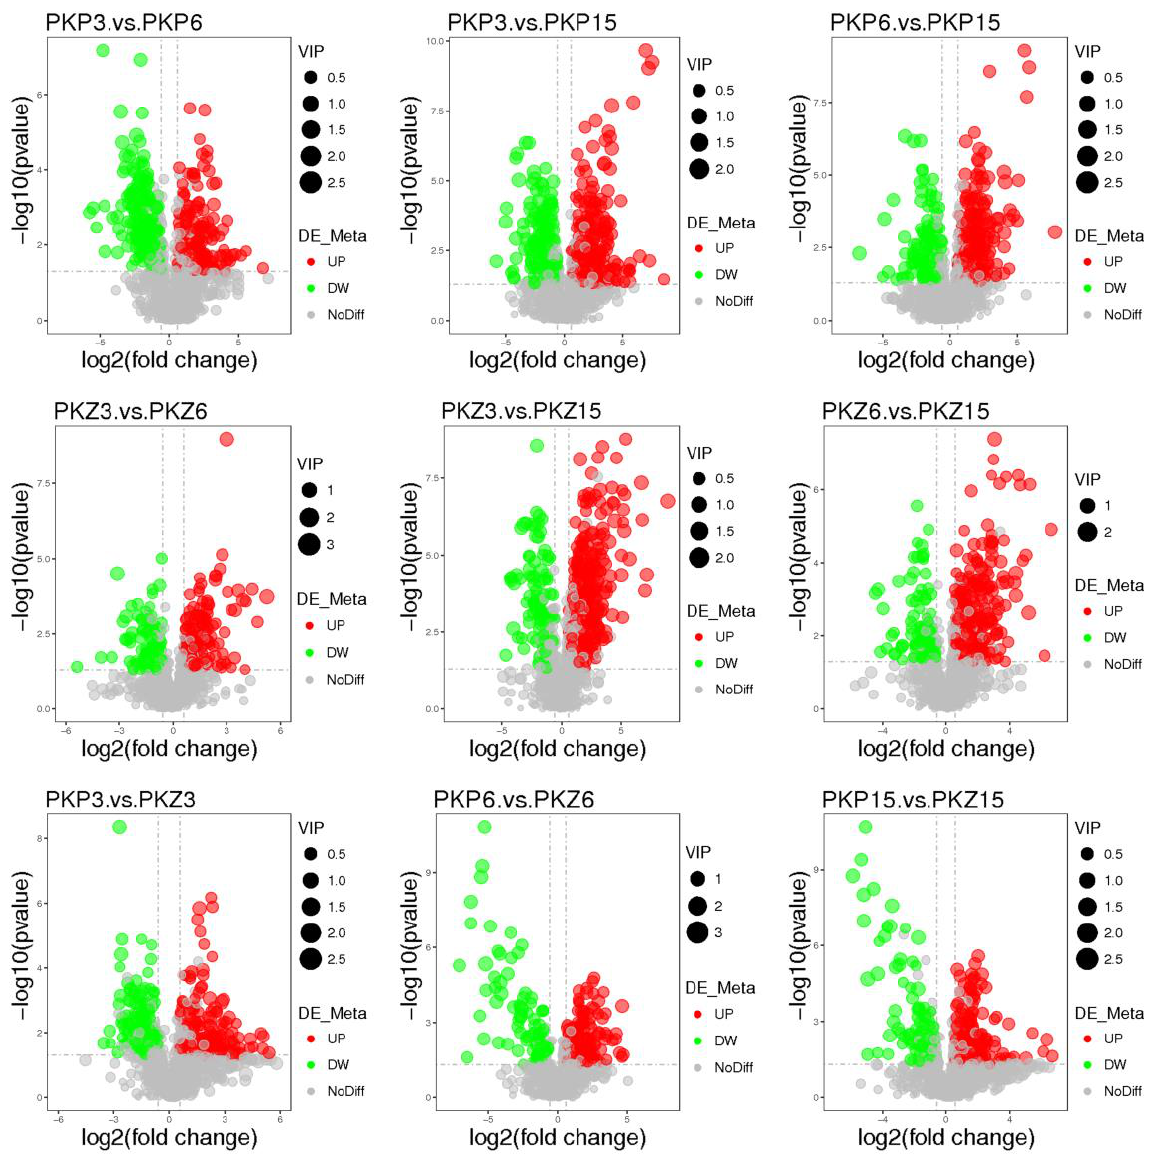
Figure 5. PLS-DA score plot of positive and negative ion modes for each comparison group (positive ion mode). The horizontal axis represents the log 2 fold change of the metabolite in different groups, the vertical axis represents the different significance levels (−log 10 p -value), and each point in the volcano plot represents a metabolite. Gray dots indicate metabolites with no significant change. Red dots represent significantly upregulated metabolites, green dots represent significantly downregulated metabolites, and the dot size represents the VIP value. PKP3-PKZ15 is the same as in Table 1.